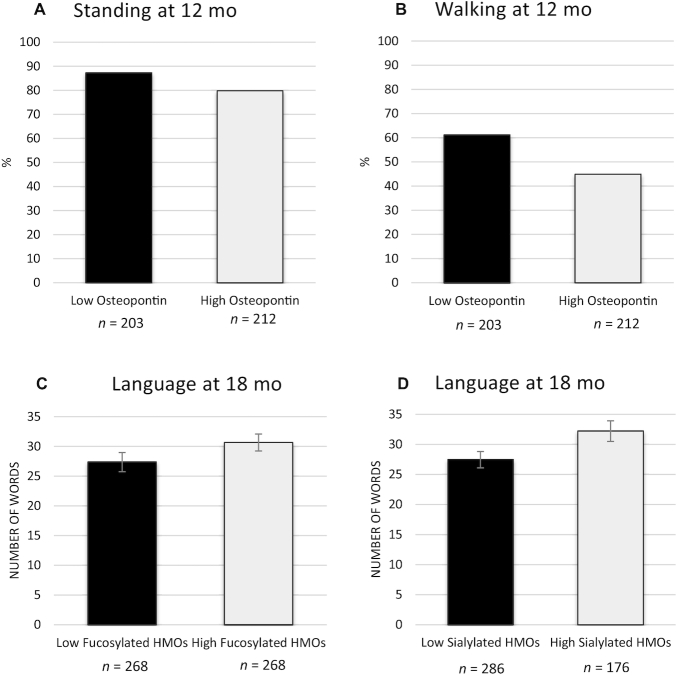
Percentage of infants standing or walking at 12 mo and mean language skills at 18 mo, in infants of secretor women with milk bioactive protein concentrations or human milk oligosaccharide (HMO) abundances below vs. above the median. Differences were assessed by generalized linear models. (A) Percentage of infants who were able to stand at 12 mo among those born to women with low vs. high milk osteopontin concentration (unadjusted P = 0.041; adjusted P = 0.021). (B) Percentage of infants who were able to walk at 12 mo among those born to women with low vs. high milk osteopontin concentration (unadjusted P < 0.001; adjusted P = 0.004). (C) Mean number of words spoken by infants at 18 mo among those born to women with low vs. high relative abundance of fucosylated HMOs (unadjusted P = 0.094; adjusted P = 0.025). (D) Mean number of words spoken by infants at 18 mo among those born to women with low vs. high relative abundance of sialylated HMOs (unadjusted P = 0.023; adjusted P = 0.026).